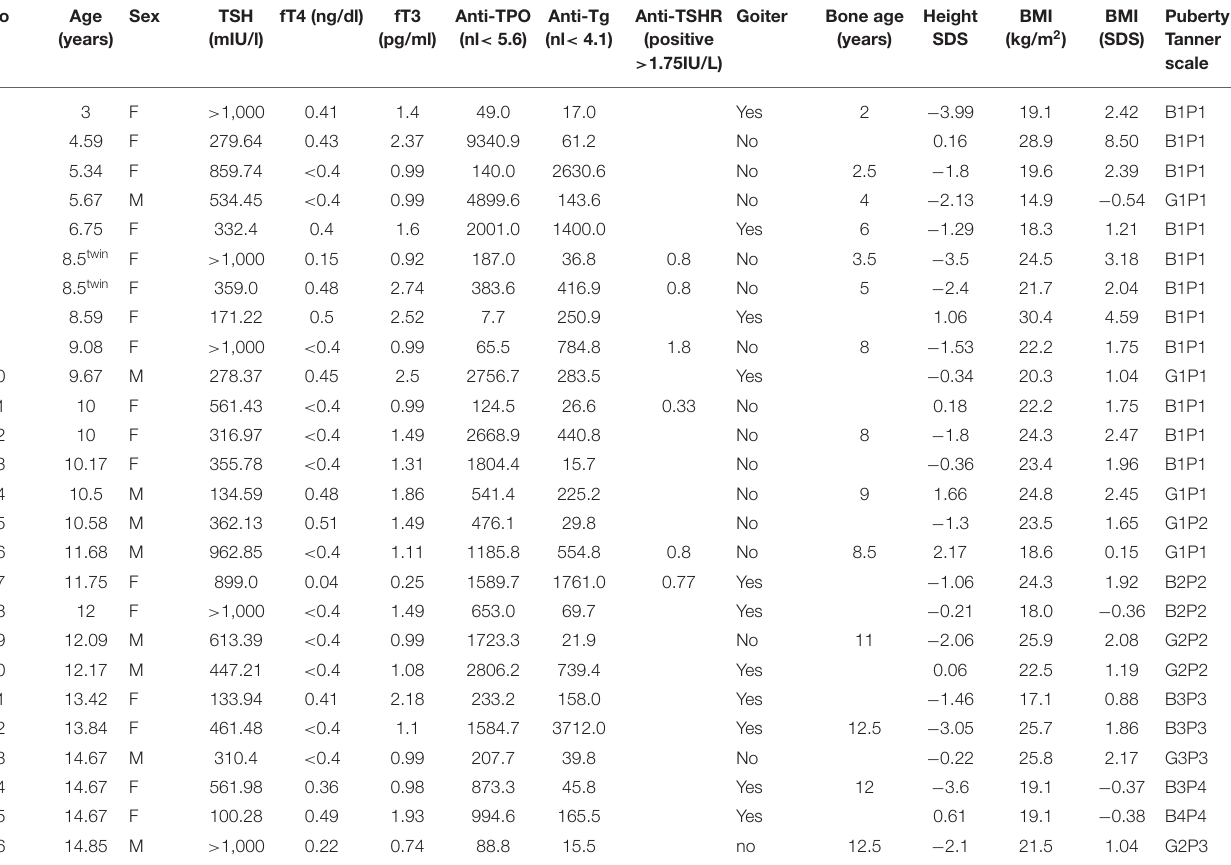
TABLE 2 | The auxological characteristics and hormonal and antibodies profile in patients with severe